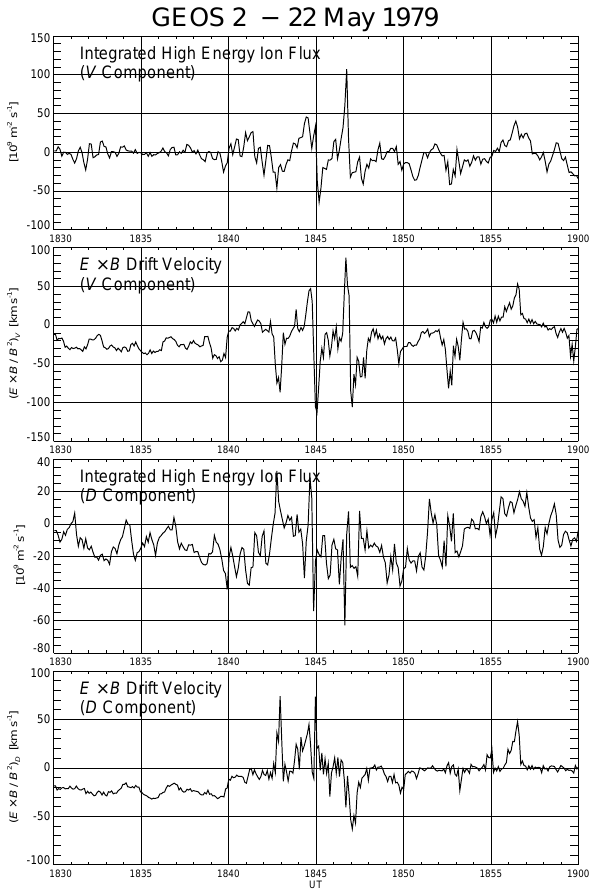
Fig. 8. GEOS-2 measurements as functions of time. From top to bottom: 1. High energy ( > 33 keV) radial ion flux intensity; 2. Calculated radial E × B -drift velocity; 3. High energy ( > 33 keV) azimuthal ion flux intensity; 4. Calculated azimuthal E × B –drift velocity.